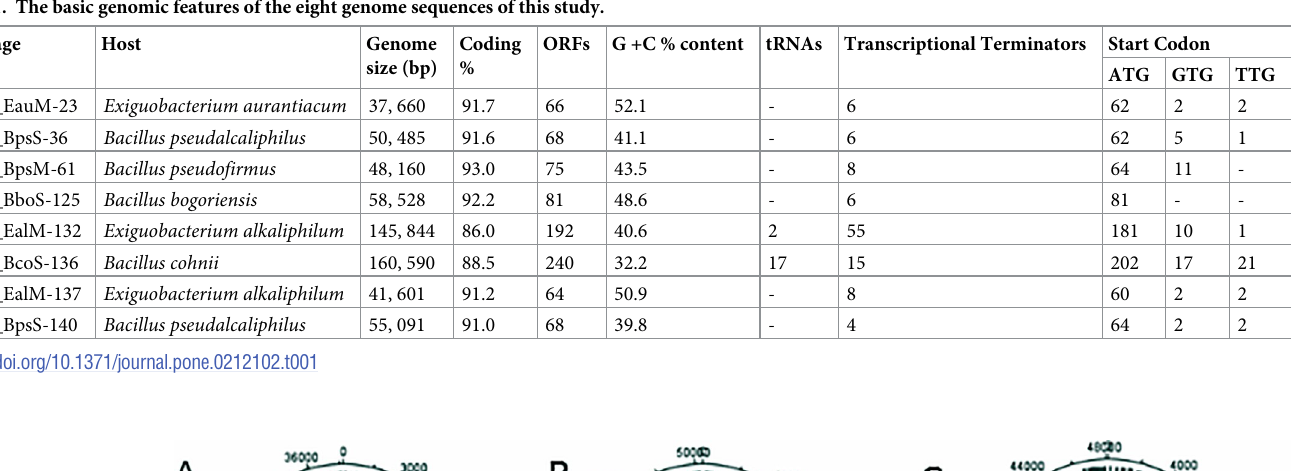
PLOS ONE | https://doi.org/10.1371/journal.pone.0212102 February 14,